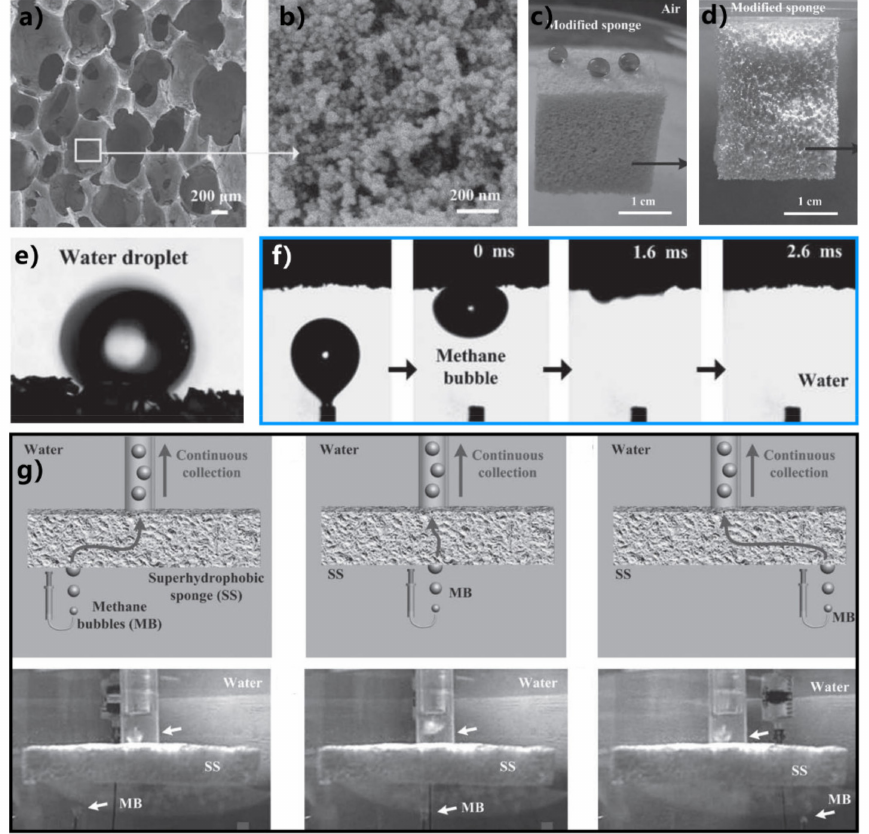
Figure 29. Collecting bubbles by a superaerophilic sponge underwater. ( a , b ) Surface microstructure of the PU sponge coated with hydrophobic-nanoparticle/polymer composite. ( c ) Water droplets on the modified sponge. ( d ) The modified sponge in water. ( e ) Water droplet rolling on the modified sponge. ( f ) Process of a bubble of methane contacting the sponge surface in water. ( g ) Collection of methane bubbles by using the modified sponge. Reprinted with permission from ref. [345]. Copyright 2012, WILEY-VCH Verlag GmbH & Co.